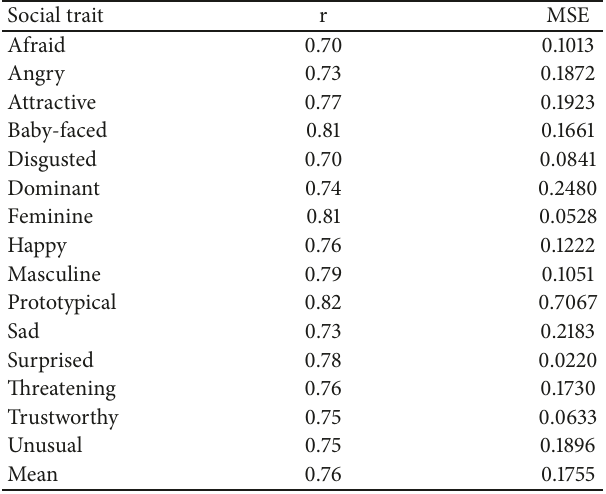
Table 2: Pearson’s r correlation coefficient and mean square errors (MSE) between the results of the models and the actual faces scores by social